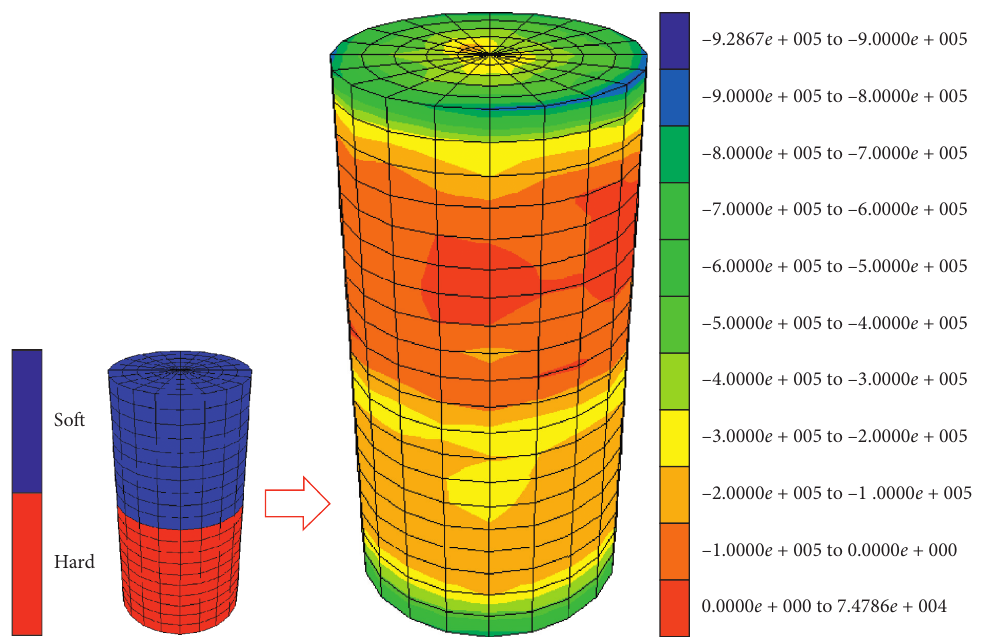
Figure 10: Nephogram of the maximum principal stress with a thickness ratio of